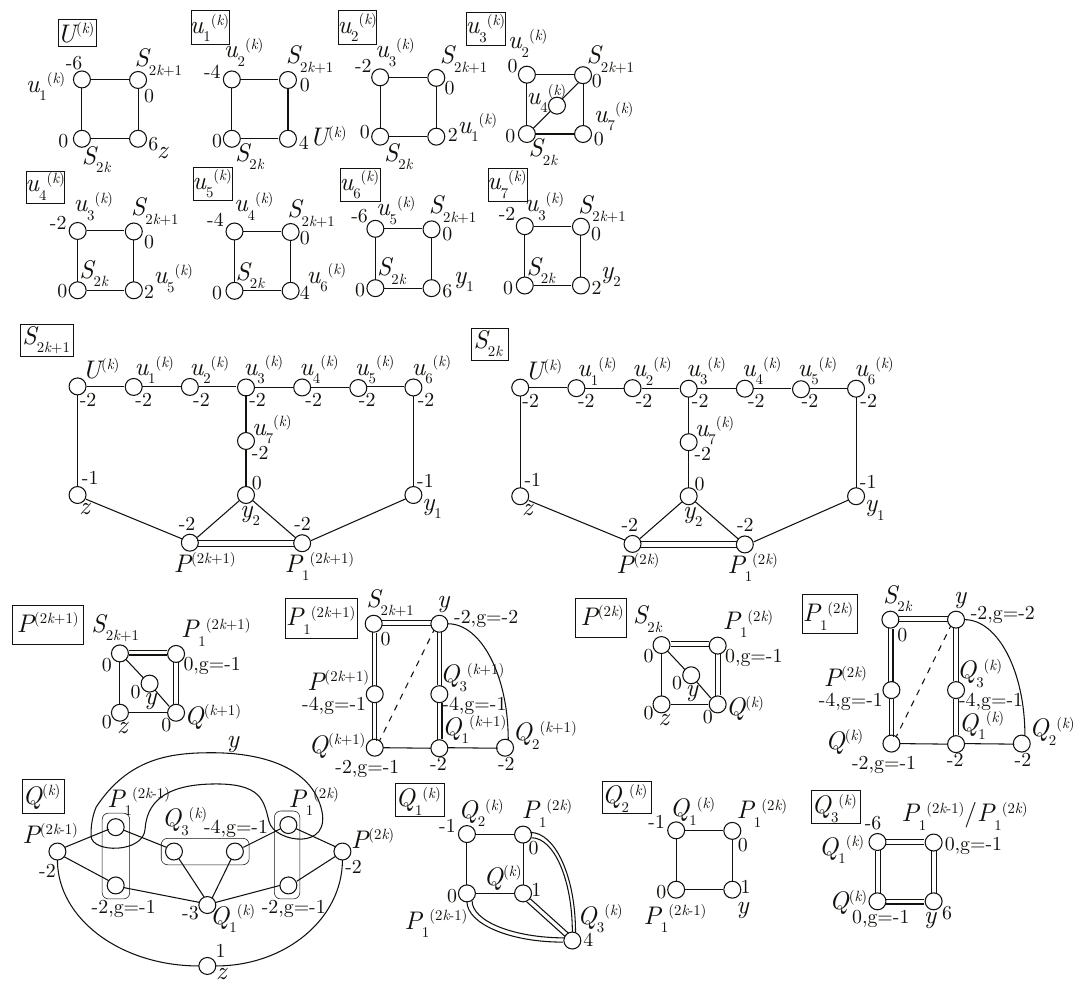
Figure 11. The con(cid:12)guration of curves in the KK resolution geometry of non-minimal ( E 7 ; E 7 ) conformal matter with order N . Dotted line means negative intersection